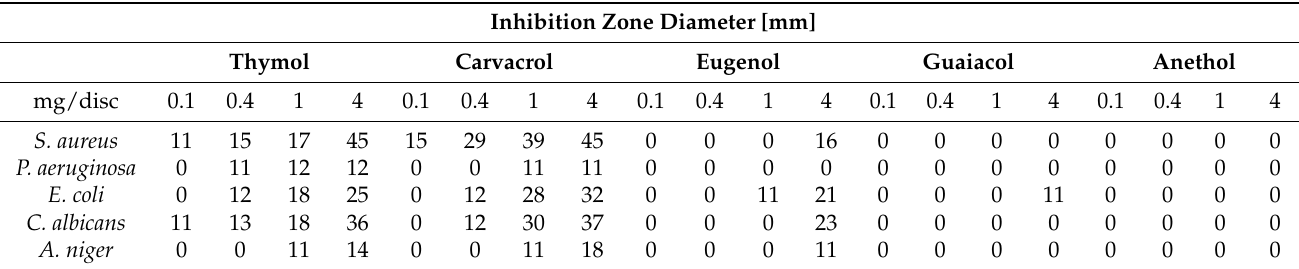
Table 1. Antimicrobial activity of tested compounds using the disc diffusion